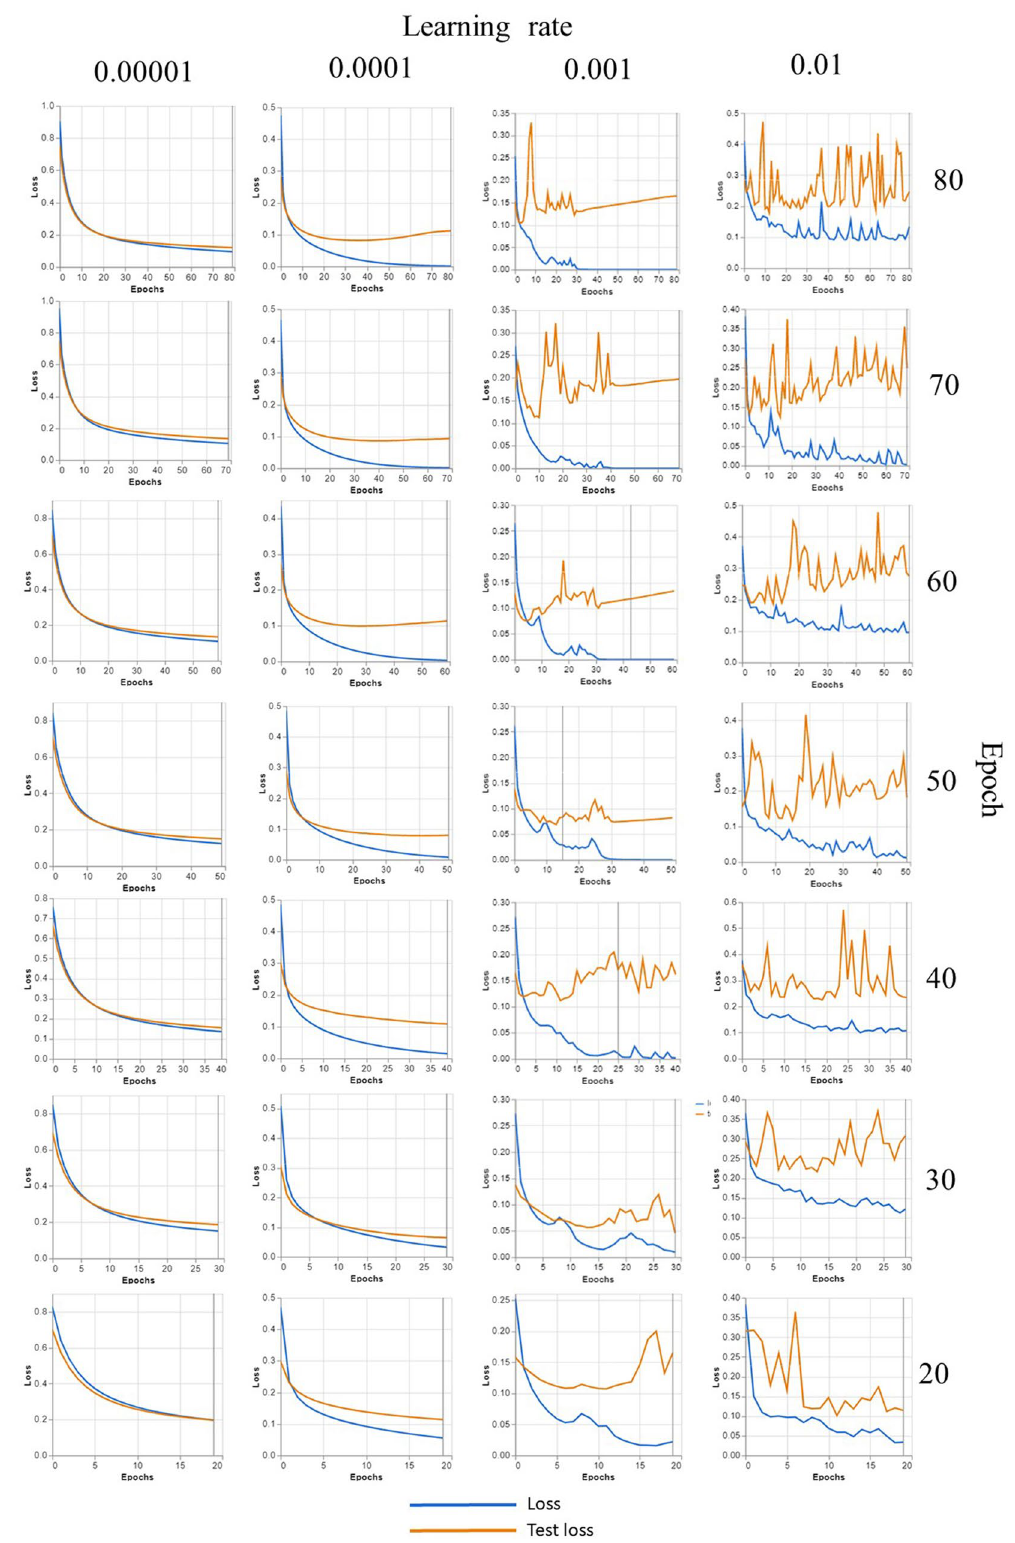
Figure 6. Accuracy and loss curve for epoch 30 that provides the highest accuracy. As seen in the figure, the learning curve experienced greater fluctuation/noise when we used a larger learning rate